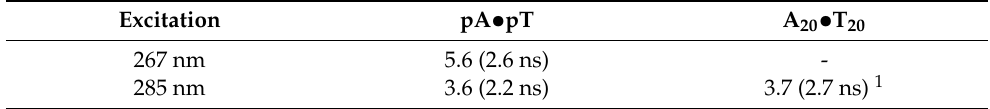
Table 2. Relative importance R of the photons emitted by the studied duplexes after 1 ns at 305 in respect to those emitted at 420 nm; the corresponding time constants 1 are shown in